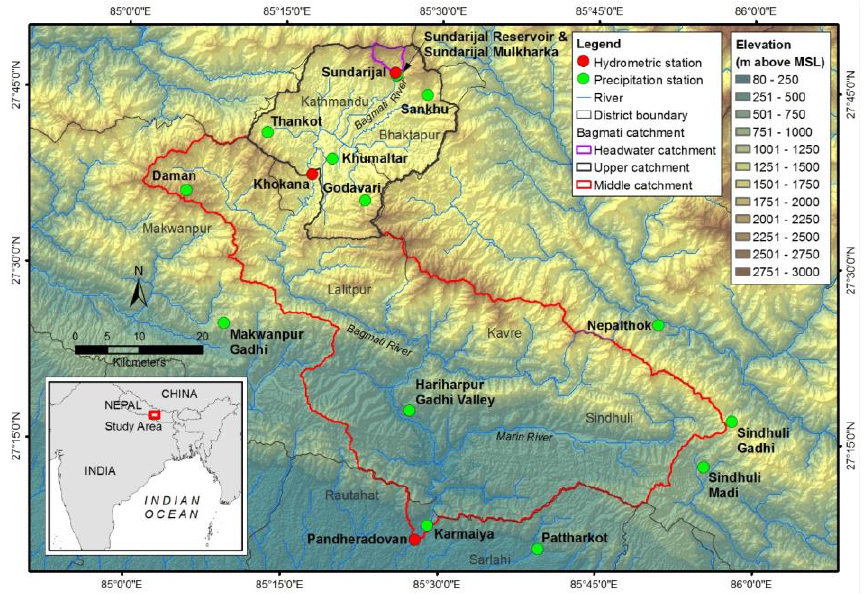
Figure 1. The Bagmati catchment and location of hydro-meteorological stations (elevation data source: